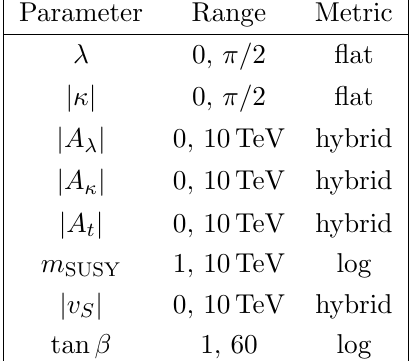
Table 1 . Ranges and metric of parameters that we scanned in the NMSSM at the SUSY scale. We considered positive and negative (cid:20) , v S and trilinear couplings. The \hybrid" metric is (cid:13)at below 10 GeV, and logarithmic elsewhere. The top mass was (cid:12)xed to its measured value 173 : 1 GeV